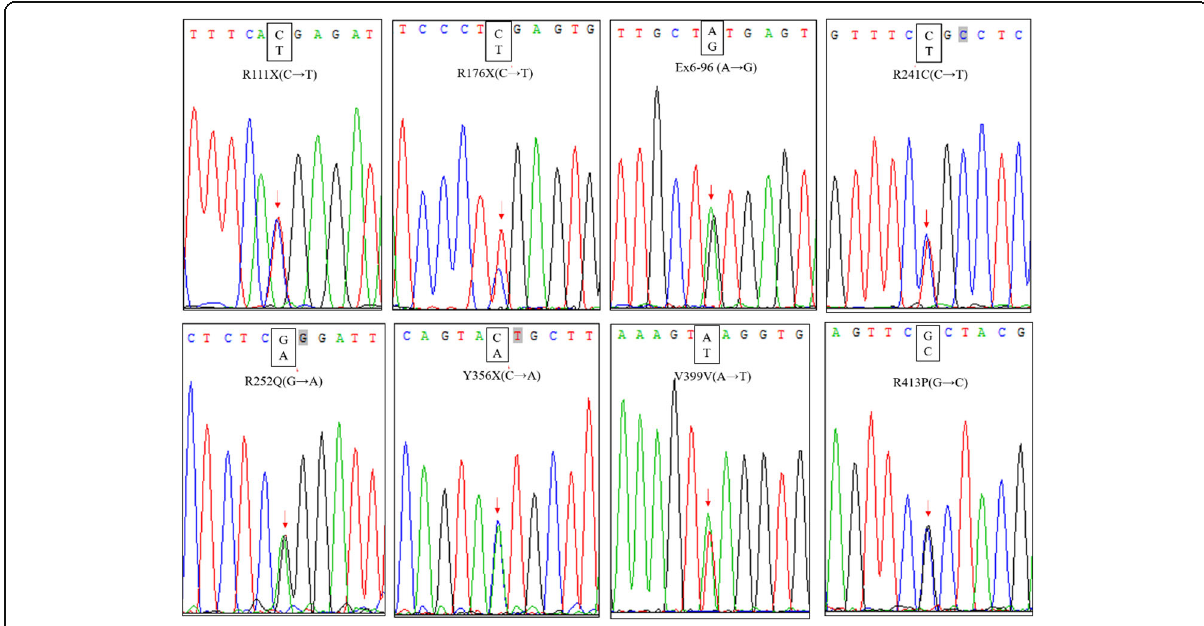
Fig. 4 Representative results of DNA sequencing analysis of PAH gene